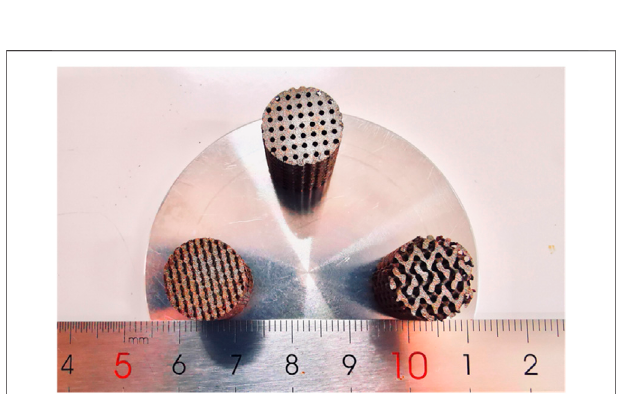
FIGURE 8 | Laser additively manufactured Fe-based scaffolds with porous